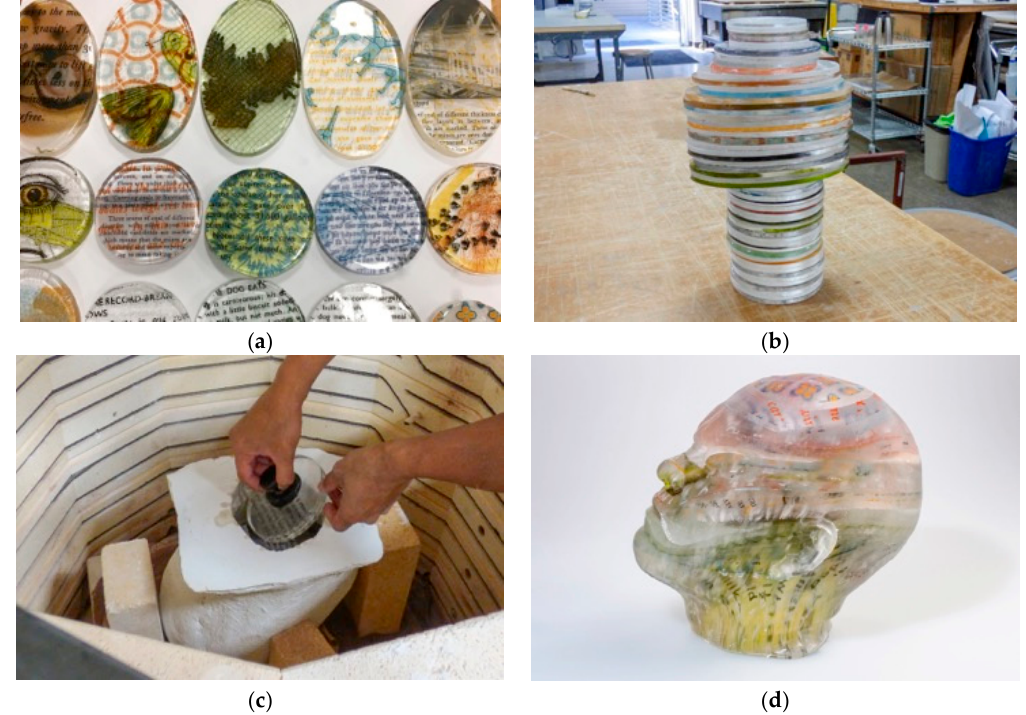
Figure 8. Process for loading kilnformed sections into lost-PLA investment mold. In the third approach,